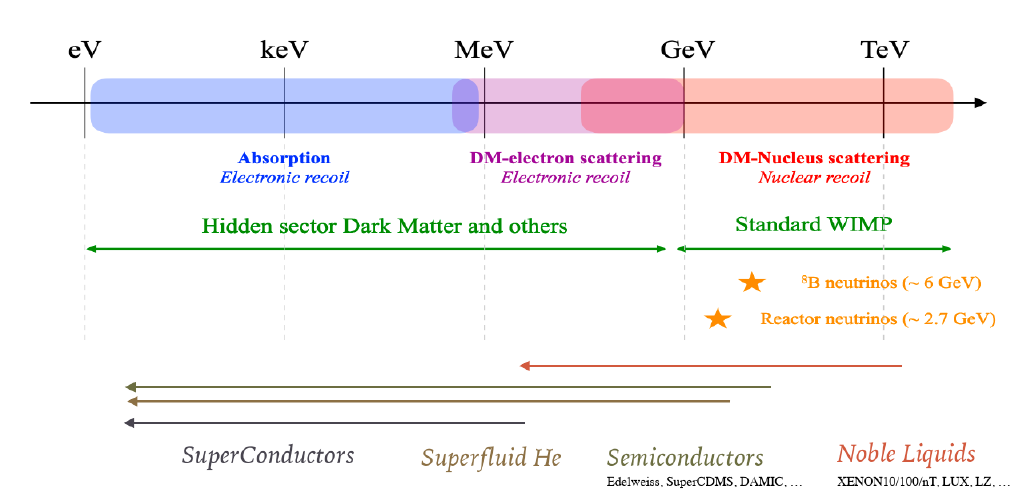
Figure 1: A logarithmic plot of possible masses for dark matter particles, as well as general techniques and specific experiments in various ranges that have, are, or will attempt to constrain dark matter in that region. In these lectures, the focus is on WIMPs whose masses are typically greater than ∼ 1 GeV / c 2